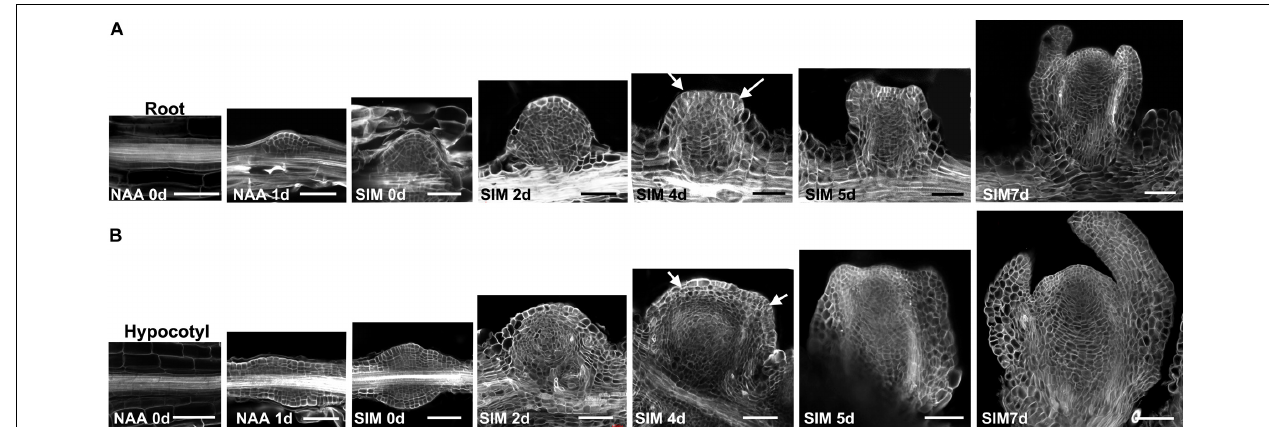
FIGURE 2 | Cytological features of shoot regeneration procedures of the bi-directional system. (A) Shoots were regenerated through direct conversion from LRP into shoot meristem. (B) Shoots were produced indirectly from the hypocotyl-derived callus. Days after NAA-treatment or SIM-culture are indicated in the bottom left corner of each panel. Arrows point to the position of leaf primordia. Scale bars represent 50 µ m.